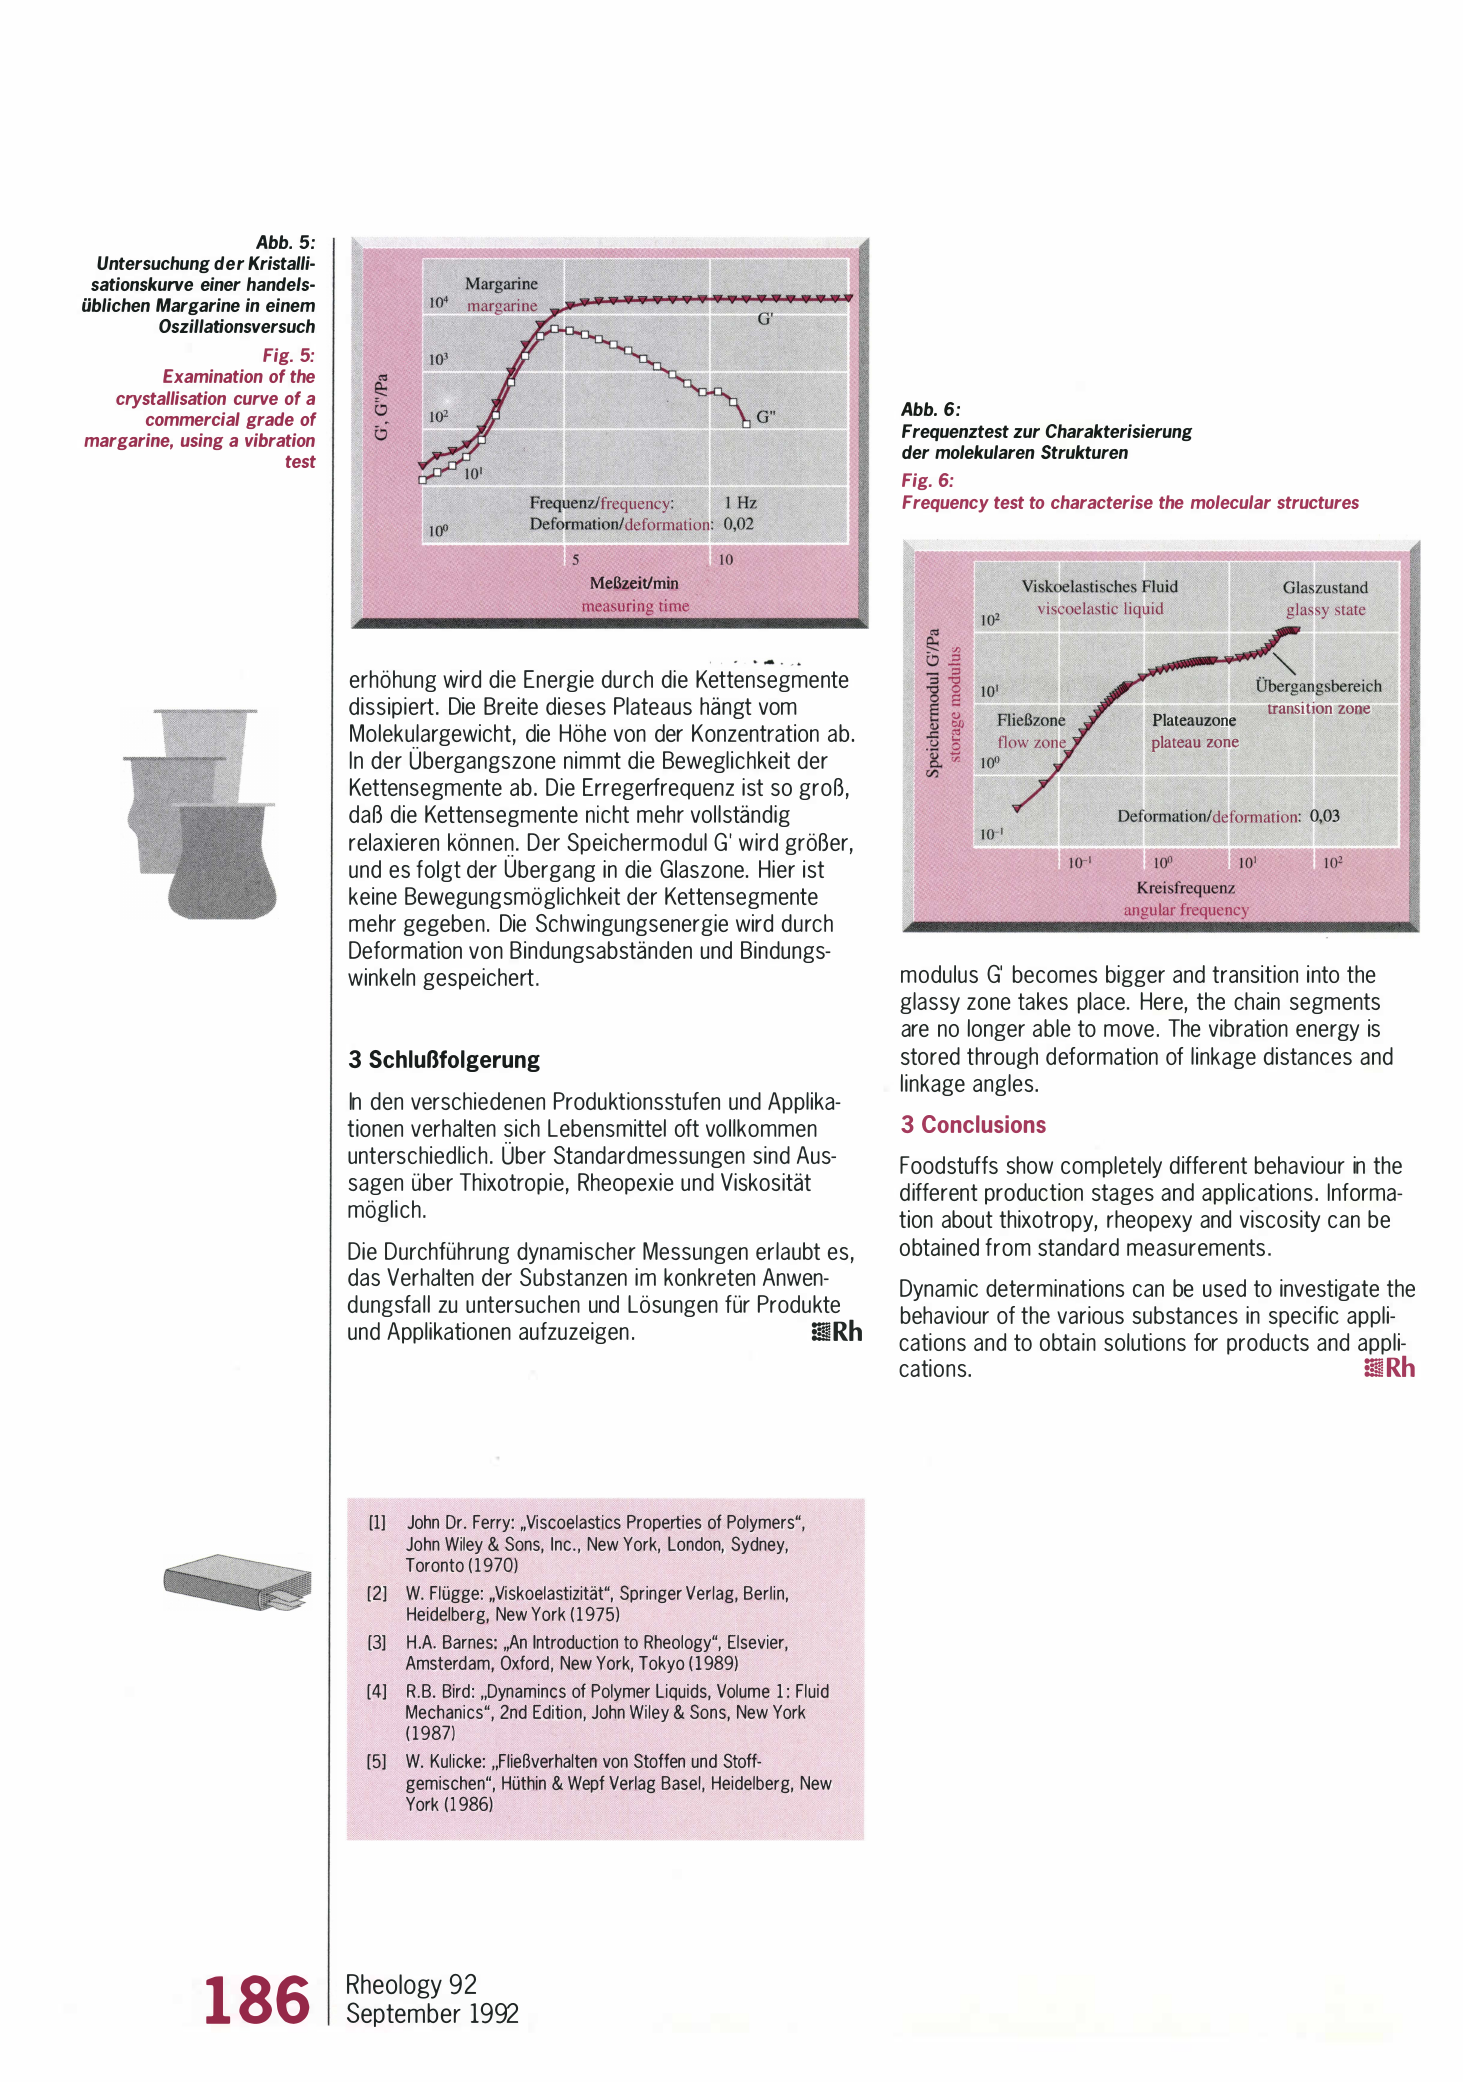
Abb. 6: Frequenztest zur Charakterisierung der molekularen Strukturen Fig. 6: Frequency test to characterise the molecular structures